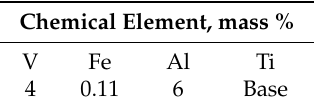
Table 1. Chemical composition of the alloy Ti-6Al-4V.